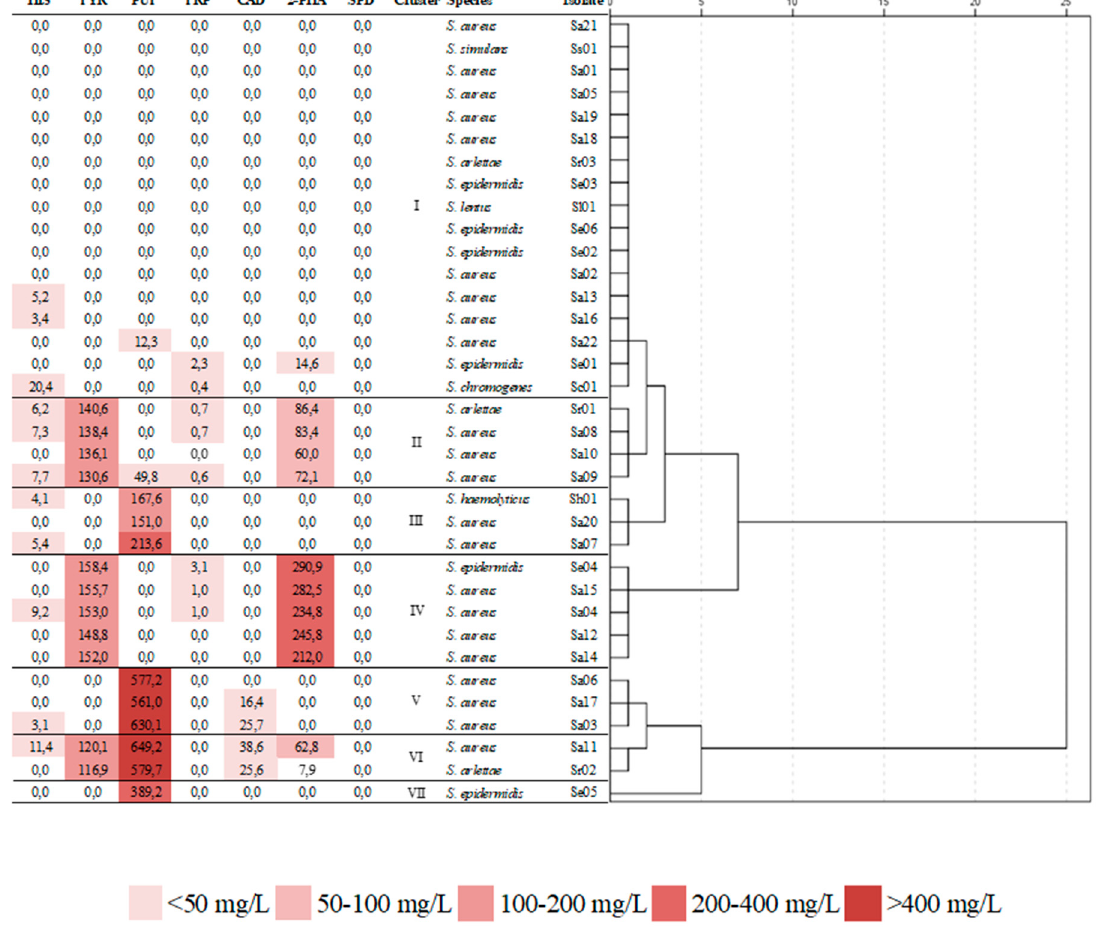
Figure 1. Abridged dendrogram of Staphylococcus strains according to their biogenic amine profile. HIS = histamine, TYR = tyramine, PUT = putrescine, TRP = tryptamine, CAD = cadaverine, 2-PHA = 2-phenylethylamine, SPD = spermidine.